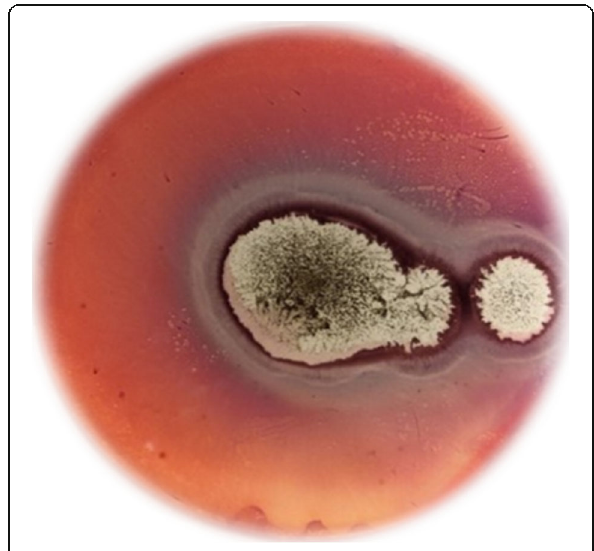
Fig. 1 Cellulase activity of Aspergillus niger in plate agar medium